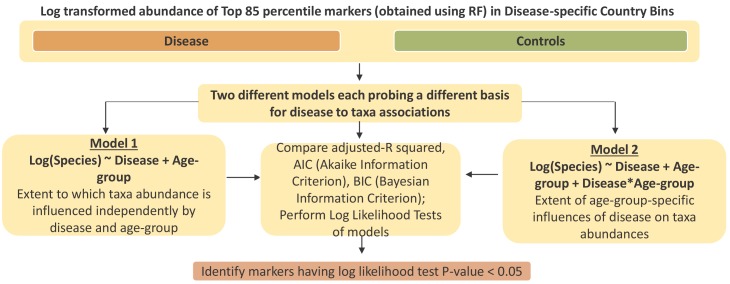
Schematic workflow describing the linear regression-based strategy to deconvolute the effect of ageing from age-specific disease association.The objective was to identify a core subset of differentially associated taxa whose age-group specific association was not a simple consequence of its abundance changing with ageing.